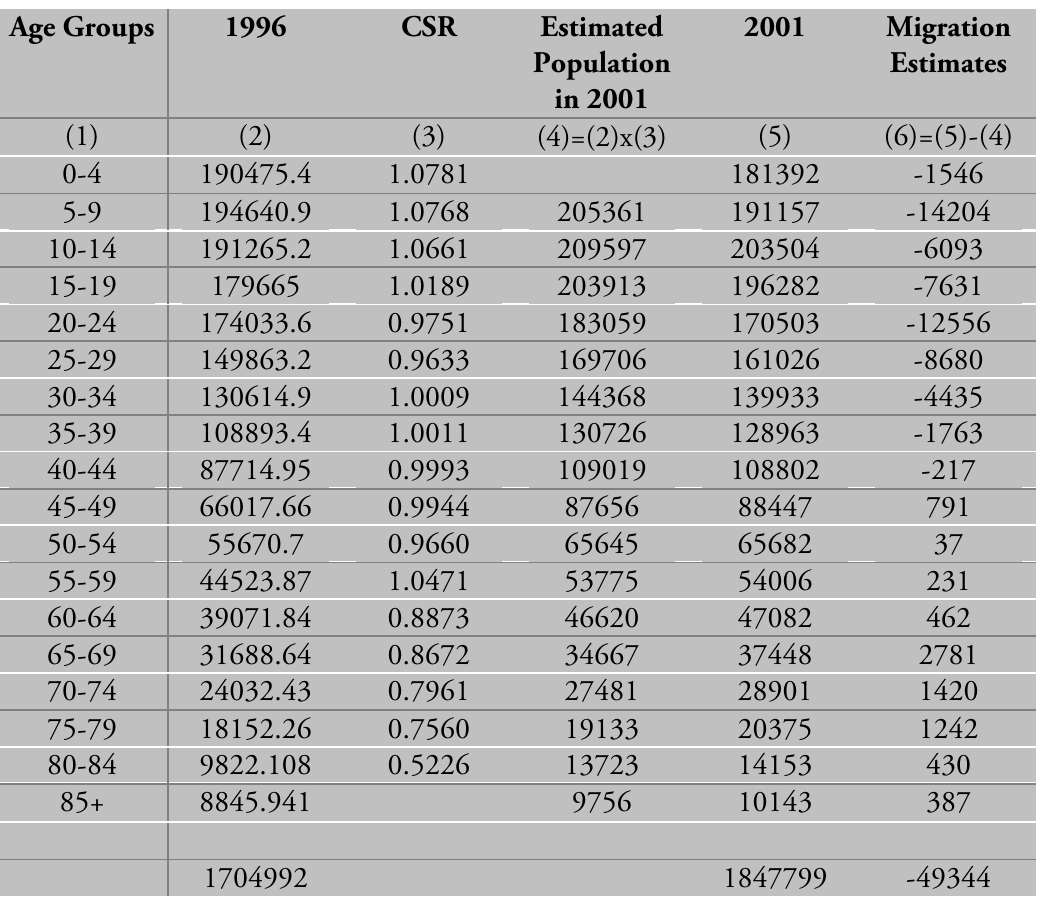
Table 3: Estimating Net Migration for North West Province using Census Survival Ratio Method,